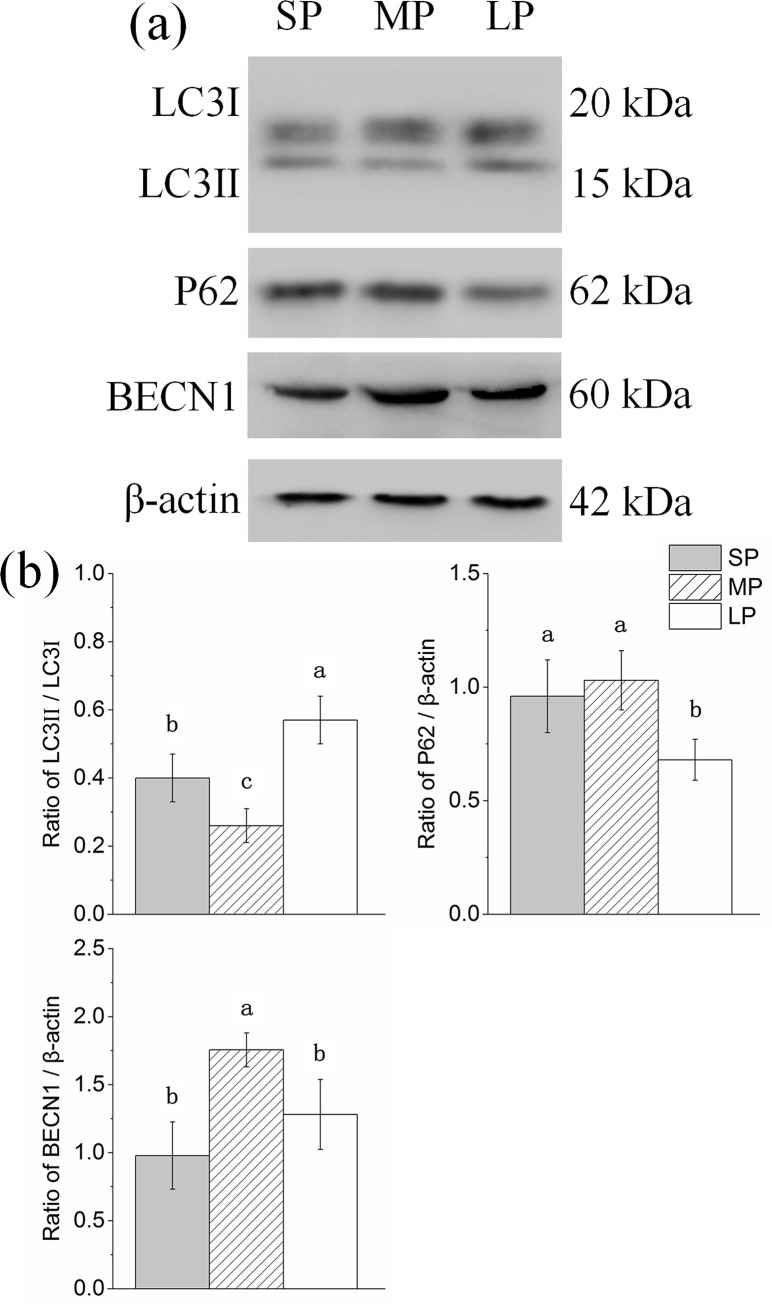
Changes in protein levels of autophagy related factors in HG of hamsters in three different photoperiodic groups.(a) Representative immunoblots of LC3, P62, BECN1 and β-actin in three different photoperiodic groups. (b) Ratio of LC3, P62, BECN1 to β-actin in HG of hamsters in three different photoperiodic groups. Values are means ± SD. n = 10. SP, short photoperiod; MP, moderate photoperiod; LP, long photoperiod. Different letters identify statistically significant difference (P < 0.05).